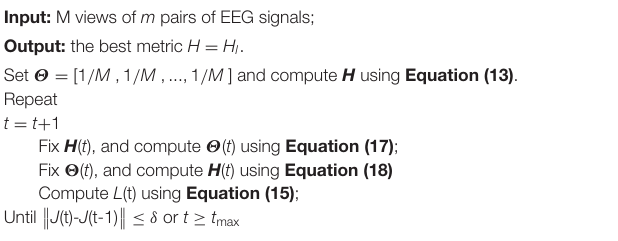
Algorithm 1 | The proposed AMDML method.